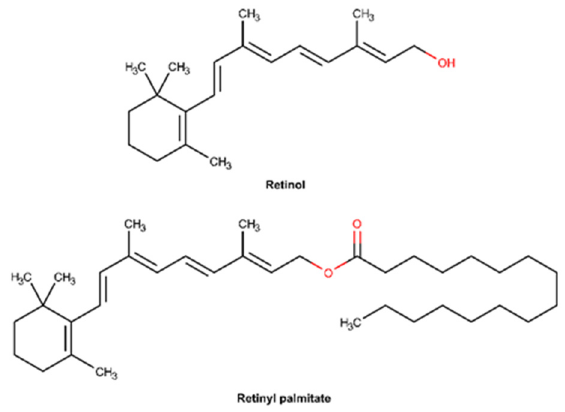
Figure 13. Chemical structure of retinol and retinyl palmitate.